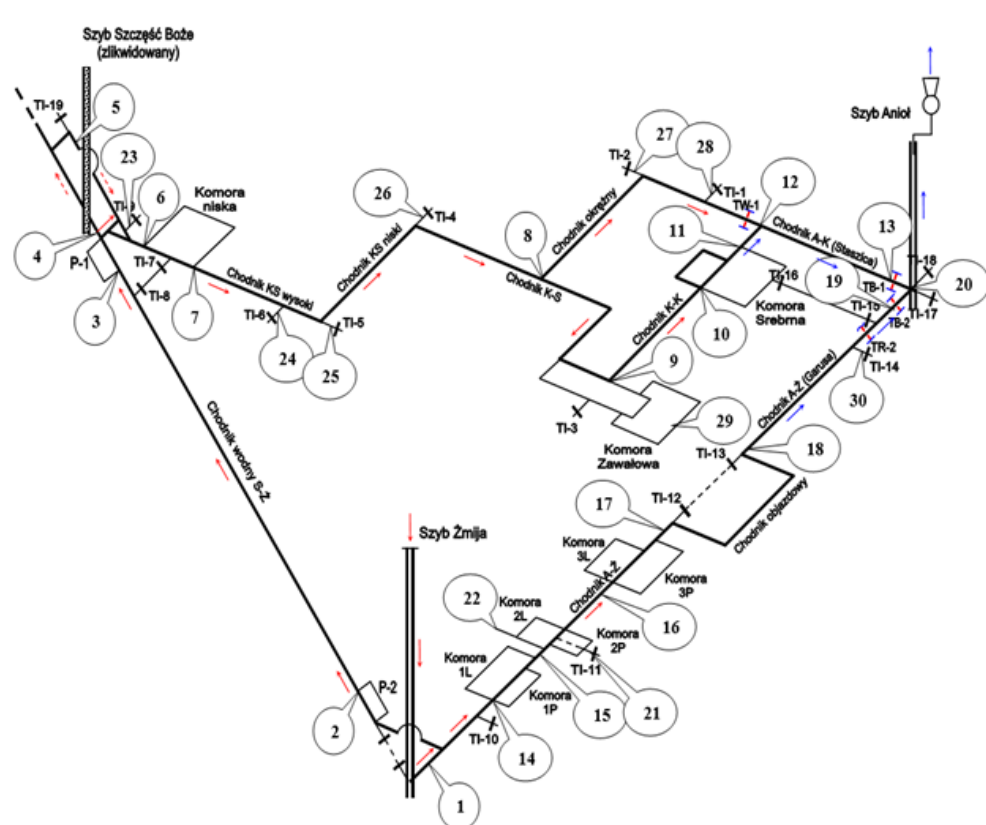
Figure 2. Location of radon measurement points with ventilation network diagram; 1—“